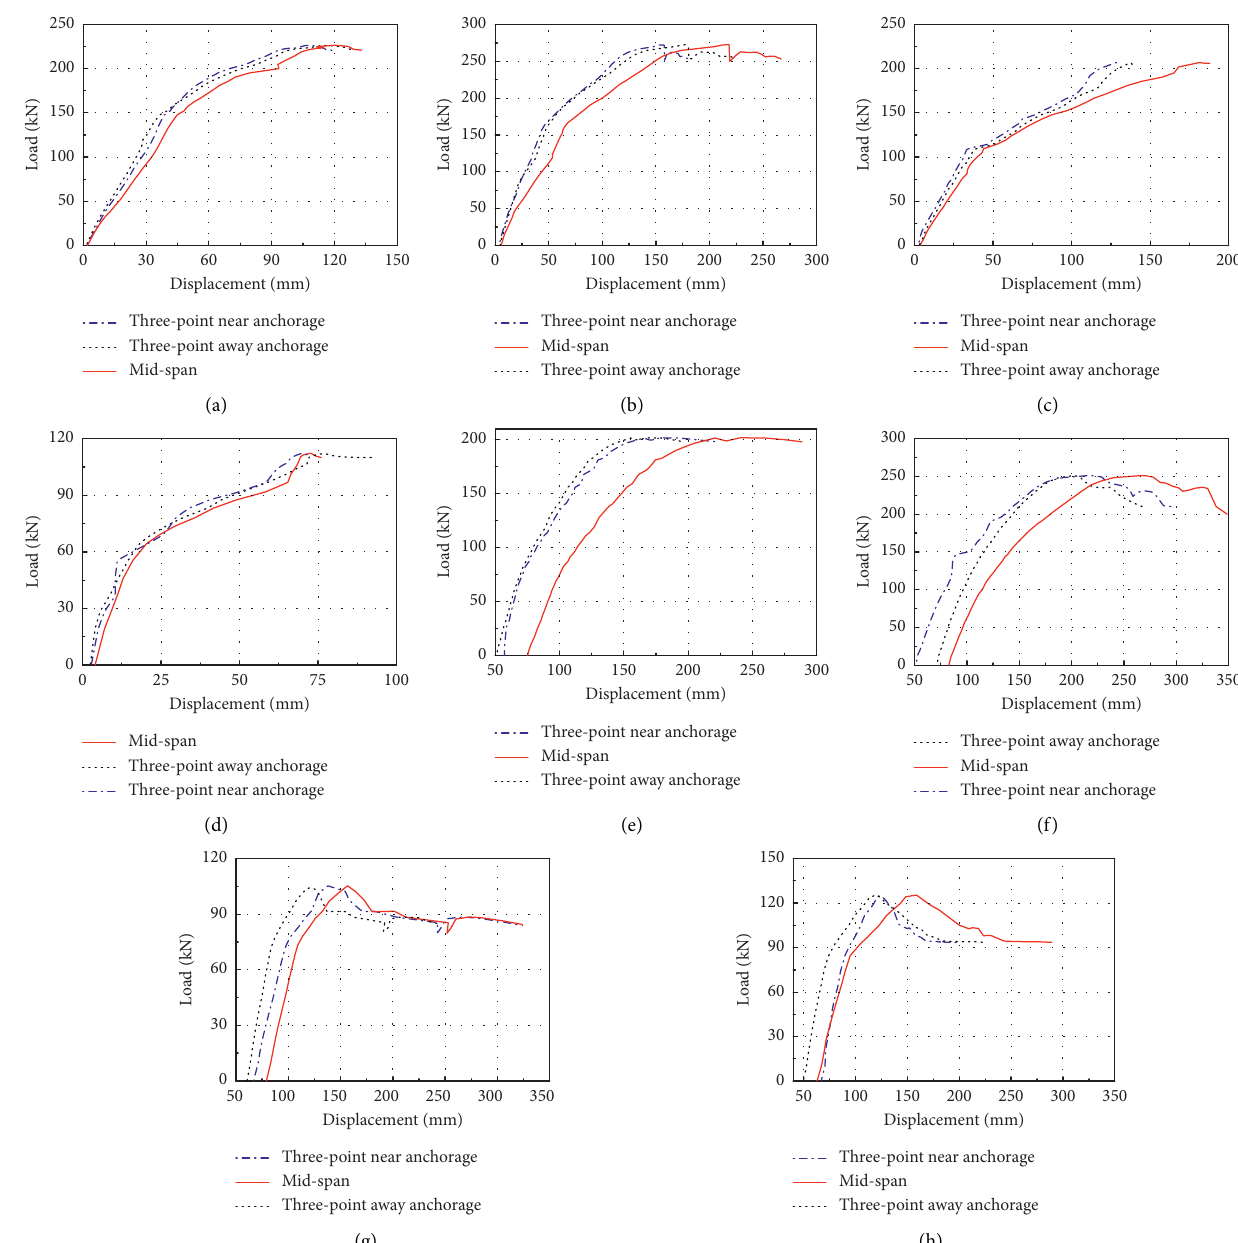
Figure 9: The load-midspan displacement curves for the specimens. (a) PRPCB1. (b) PRPCB2. (c) PRPCB3. (d) PRPCB4. (e) PRPCB5. (f) PRPCB6. (g) UPRPCB1. (h)